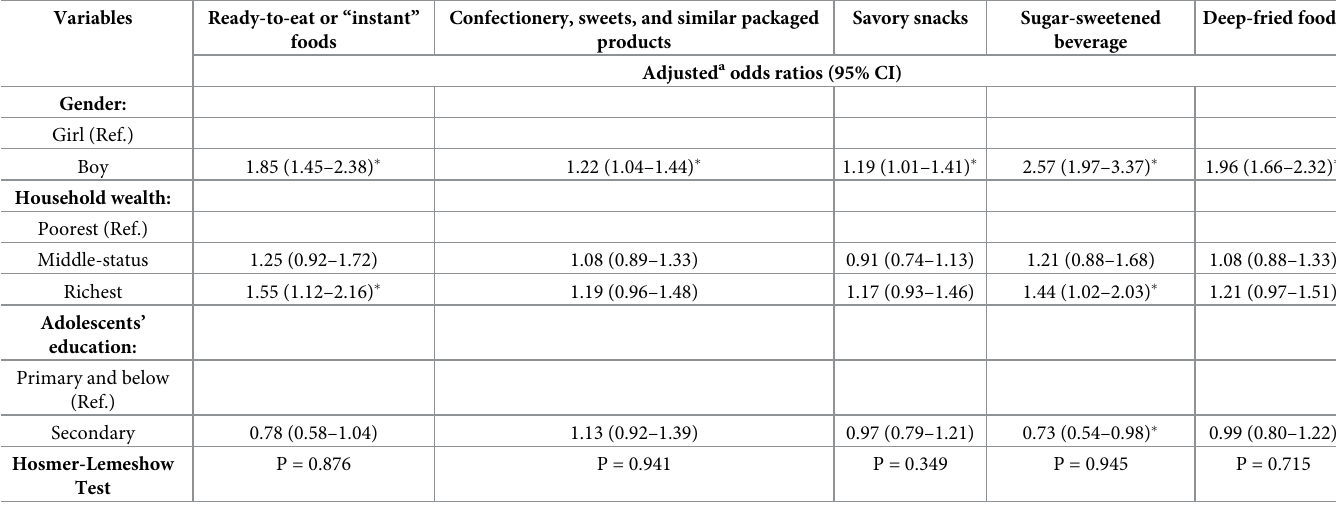
Table 3. Logistic regression analyses of association between socio-demographic variables and consumption of ultra-processed and deep-fried foods. Variables Ready-to-eat or “instant” Confectionery, sweets, and similar packaged Savory foods products